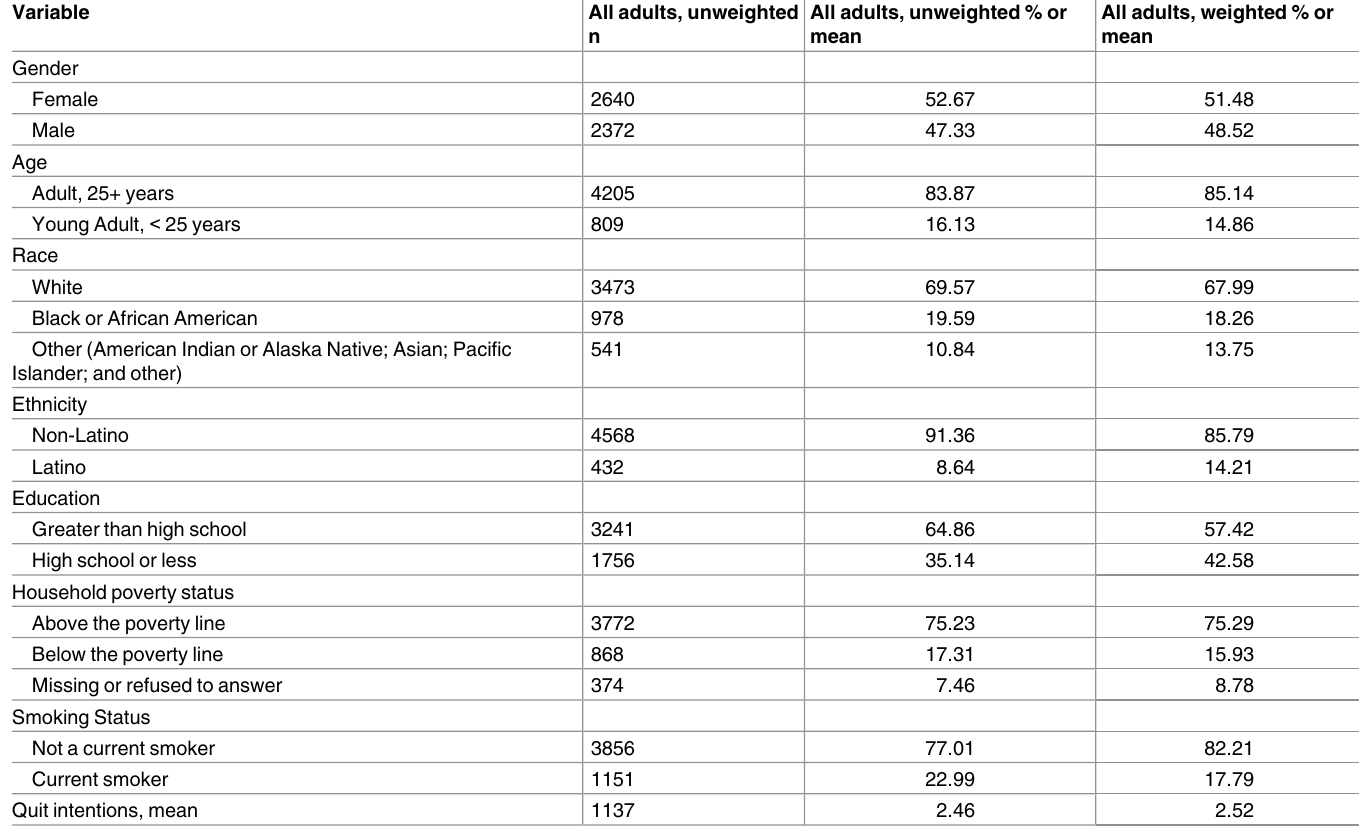
Table 1. Unweighted and weighted percentages for demographic and smoking-related